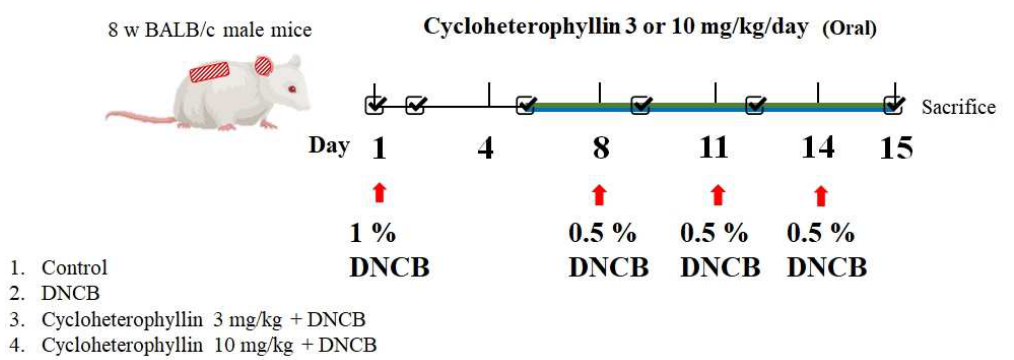
Figure 9. Experimental design of a mouse model of atopic dermatitis (AD)-like skin